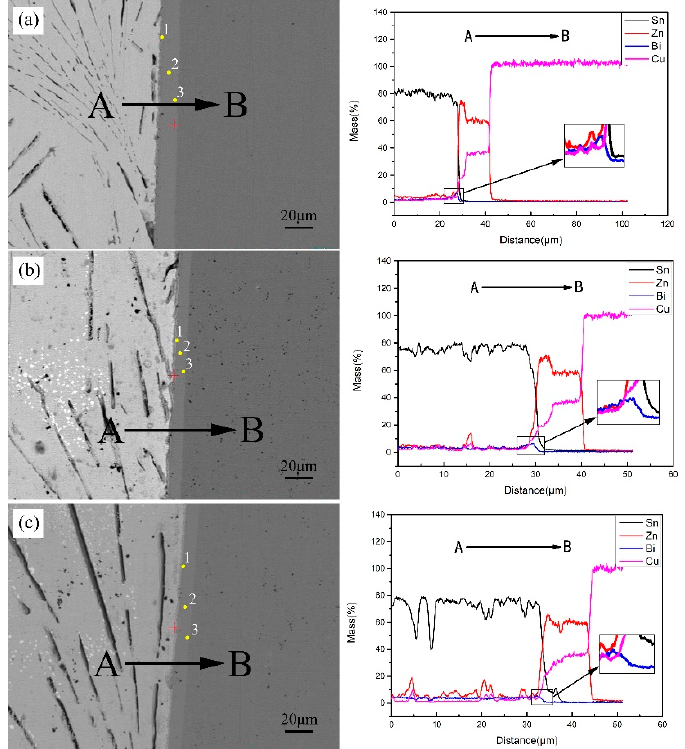
Figure 13. EPMA images and line analyses of the interface of Sn-9Zn-xBi/Cu joints: ( a ) x = 3; ( b ) x = 4; ( c ) x = 5. Table 4. Point analysis results of the IMCs, as shown in Figure 10.